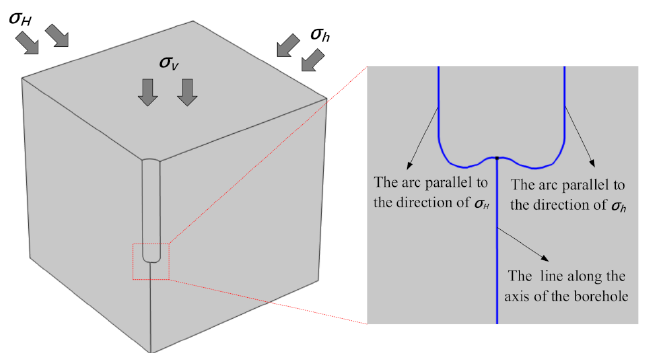
Figure 7. Points of data extraction in the analysis of the bottomhole stress